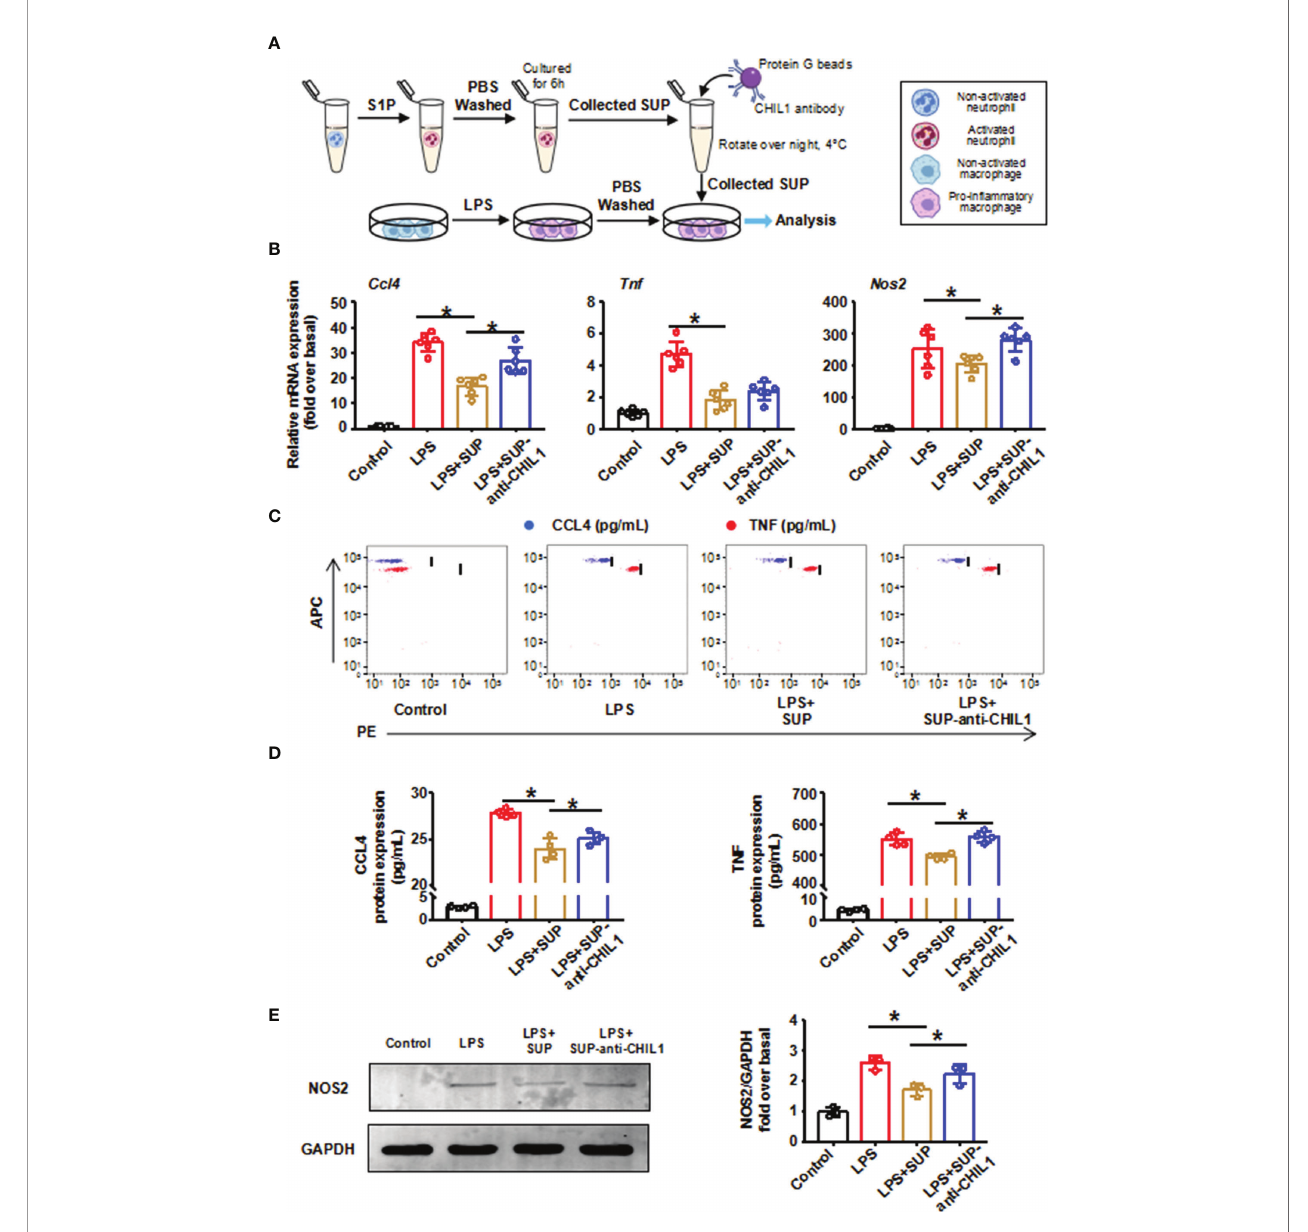
FIGURE 7 | Immunodepletion of CHIL1 in A-Neu supernatant attenuated the inhibitory effect on pro-in fl ammatory macrophages. (A) Schematic representation of the experimental design: bone marrow-derived macrophages were stimulated with LPS 10 ng/mL for 3 hours, washed with PBS, and then cultured in the presence of A-Neu supernatant (SUP) or A-Neu supernatant immunodepleted with anti-CHIL1 (SUP-anti-CHIL1). Expressions of CCL4, TNF and NOS2 in indicated groups were detected by RT-qPCR ( B , n=6), CBA ( C, D , n=4) and WB ( E , n=3). The results were presented as mean ± SD. One-way ANOVA was used. *P < 0.05. A-Neu, activated neutrophil; N-Neu, non-activated neutrophil; SUP, activated neutrophil supernatant; SUP-anti-CHIL1, activated neutrophil supernatant immunodepletion CHIL1; Ccl4, C-C chemokine motif ligand 4; Tnf, tumor necrosis factor; Nos2, nitric oxide synthase 2; LPS,